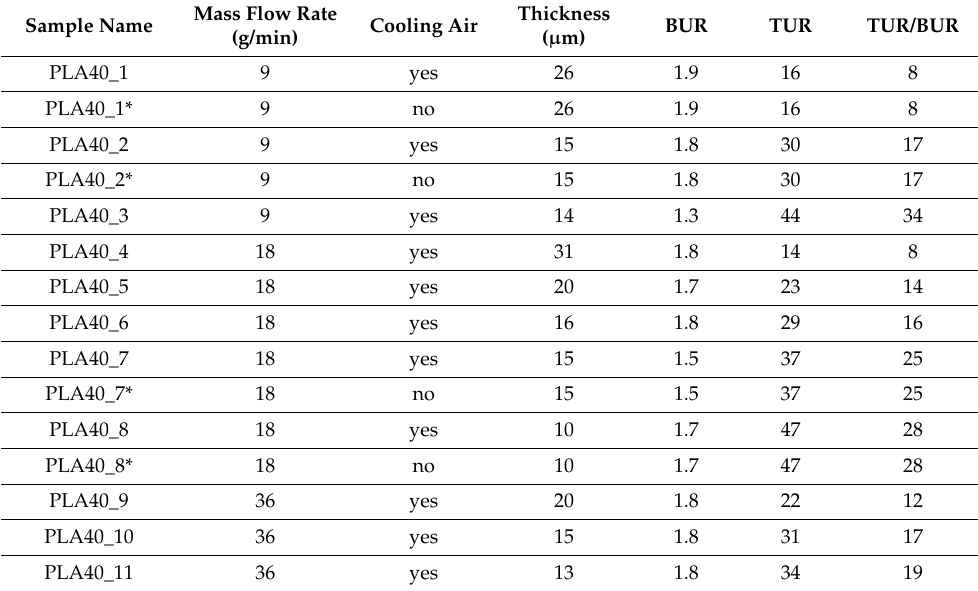
Table 1. Films produced from the blend PLA/PBAT 40/60 + 1 wt % Joncryl with their respective process conditions. Films with an asterisk are those produced without cooling air.